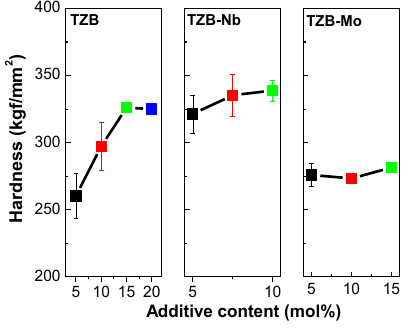
Figure 7. Knoop hardness (H K ) of the TeO 2 –BaO–ZnO glass system varied with different additive concentrations.